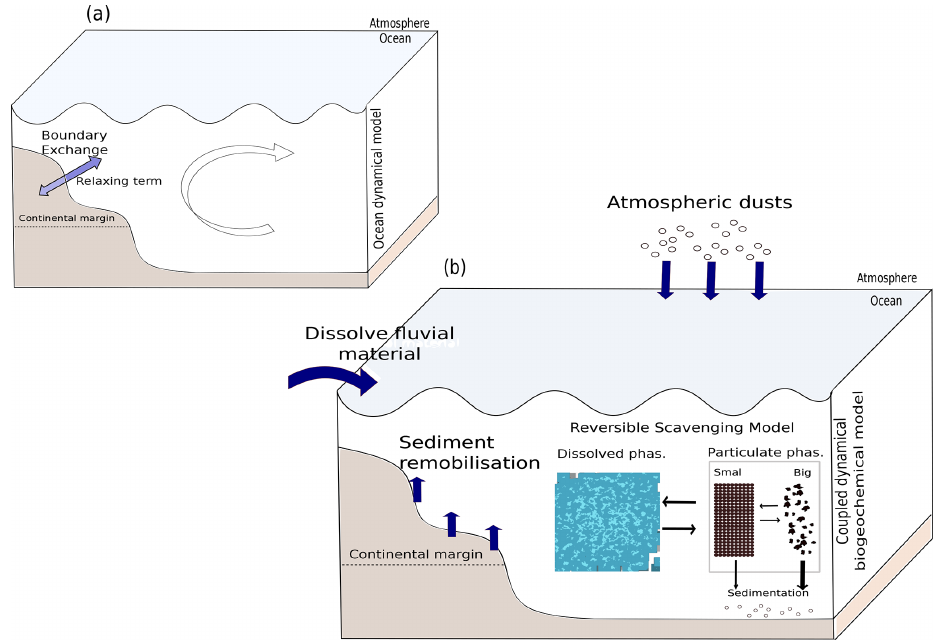
Figure 1. Presentation of the main Nd oceanic modelling approach in the Mediterranean Sea. (a) Modelling only the Nd isotopic composition ( ε Nd), focused on the role of boundary exchange with the continental margin (on the first 540m) using a relaxing term (Ayache et al., 2016; Arsouze et al., 2007). (b) Explicitly representing the different sources of Nd to the ocean, e.g. sediment remobilisation (which implicitly represents the boundary exchange process), fluvial discharge, and atmospheric dust as done in Arsouze et al.